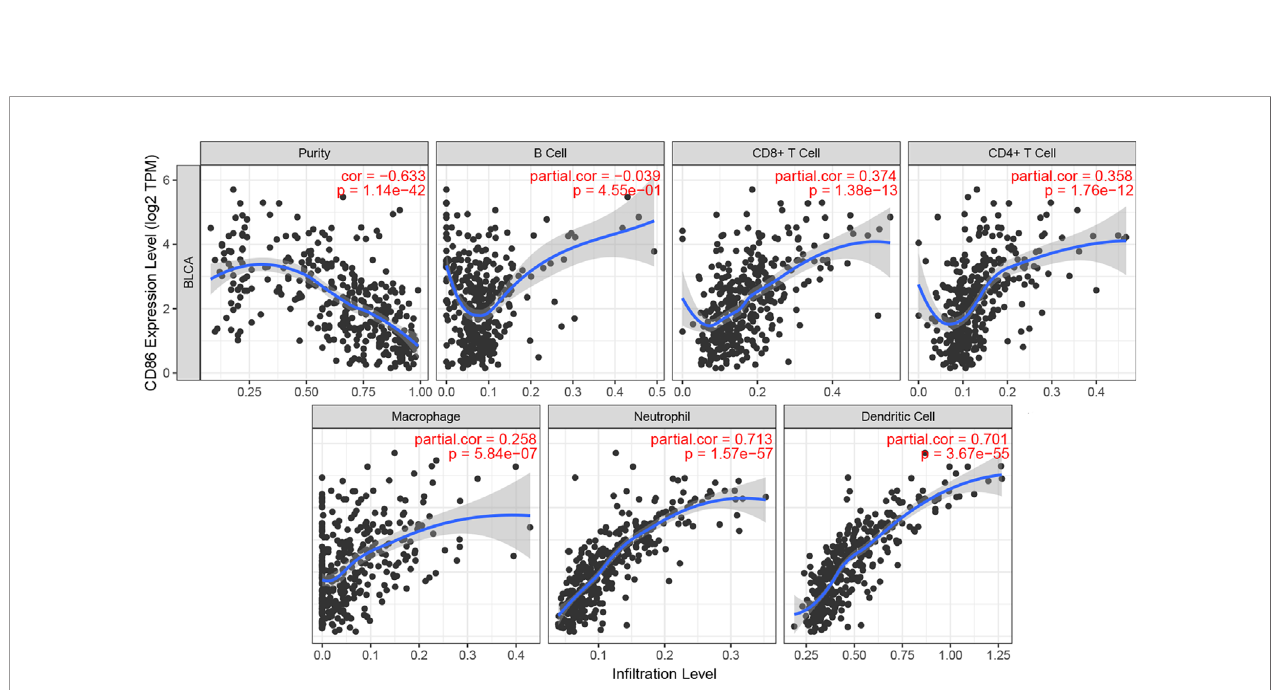
FIGURE 7 | Correlation of CD86 expression with immune in fi ltration level in